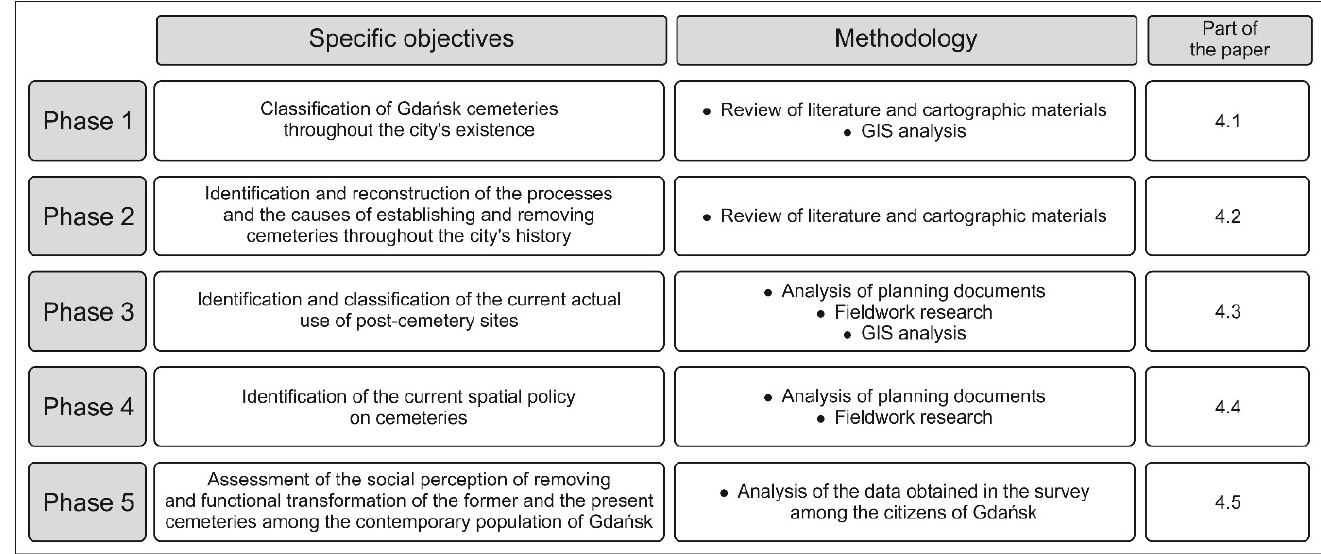
Figure 5. Research process